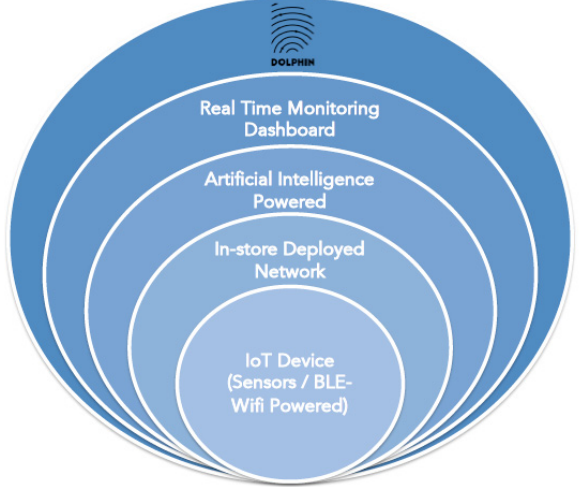
Figure 2. Sensor fusion approach with combined technologies: BLE, WiFi, and 4G.